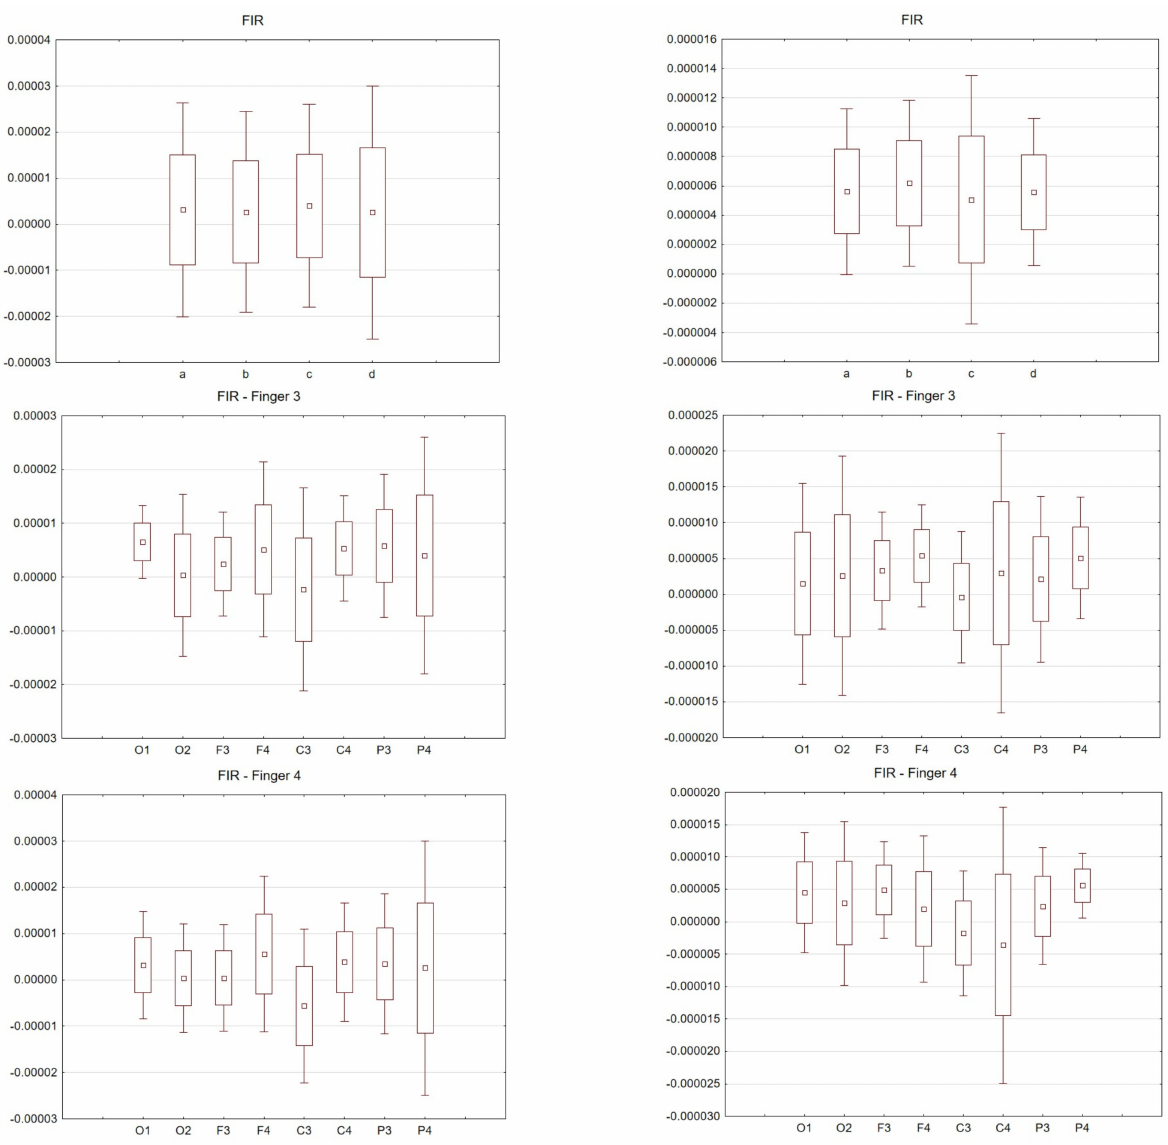
Figure 4. Wave amplitude values (V) FIR filter: Top drawing for all and individual fingers: a—all fingers, b—“2” fingers, c—“3” fingers, d—“4” fingers and electrodes P4. Middle drawing for finger 3 and all electrodes. Bottom drawing for finger 4 and all electrodes. Right hand (left in the photo) and left hand (right